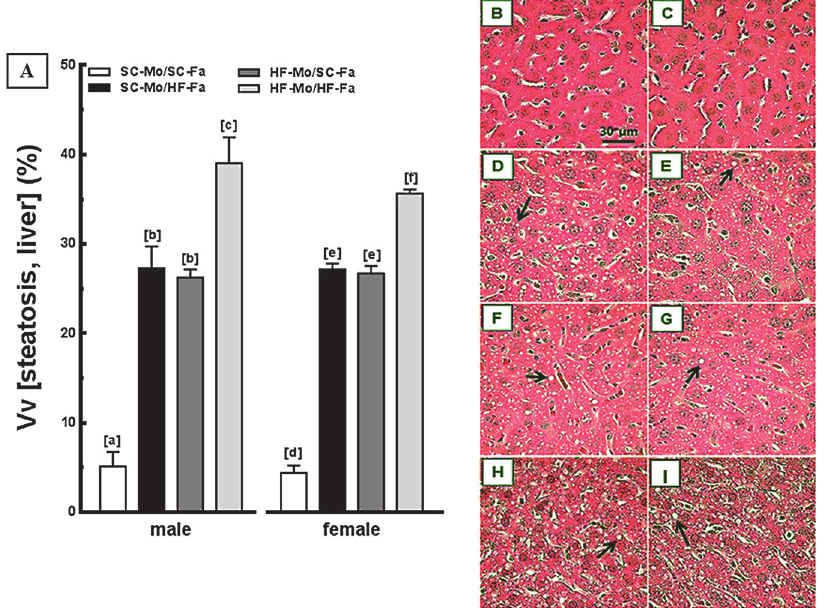
interaction between maternal diet, paternal diet and offspring sex, with males being more af- fected than the female offspring ( P < 0.0001; three-way ANOVA).